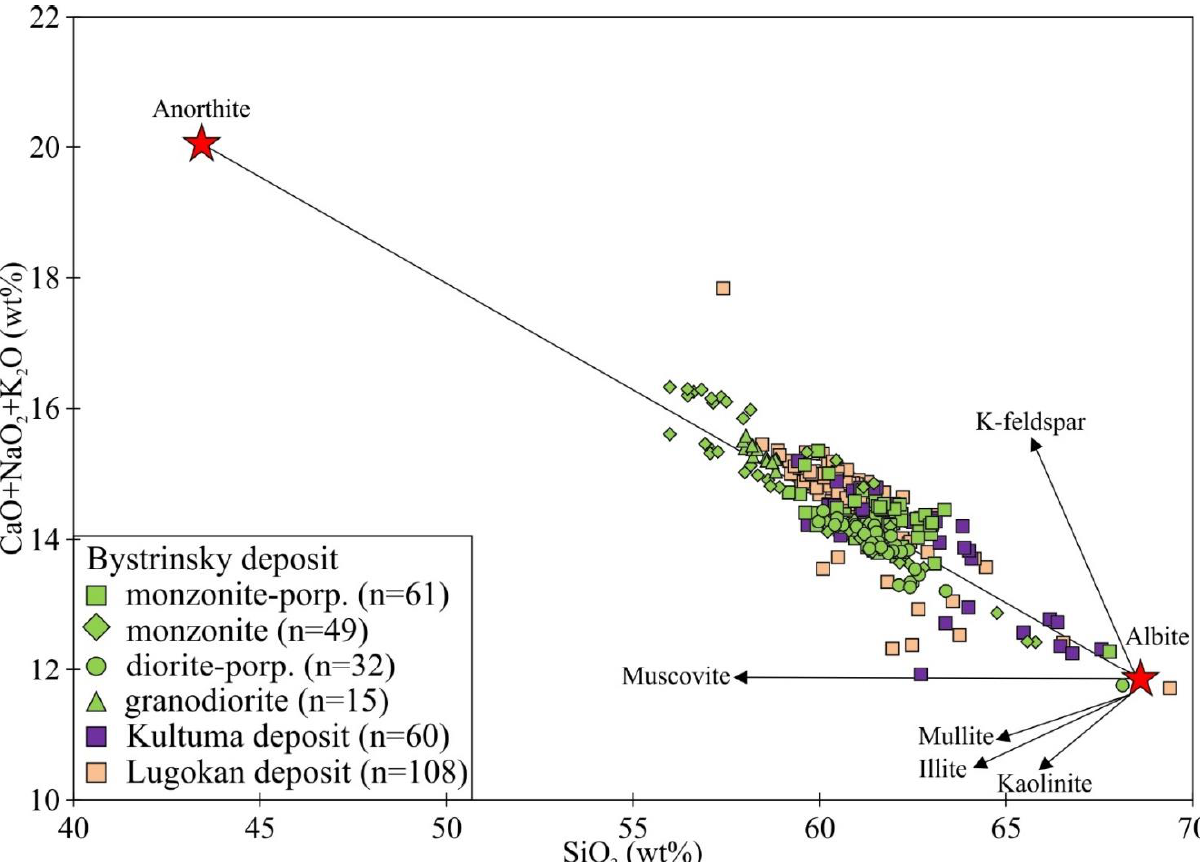
Figure 4. SiO 2 versus CaO + Na 2 O + K 2 O wt.% showing the trajectories towards common plagioclase alteration phases [7].